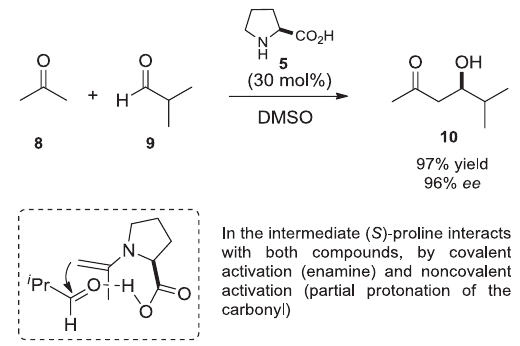
Figure 5. Direct aldol reaction catalyzed by ( S )-proline, see Ref.